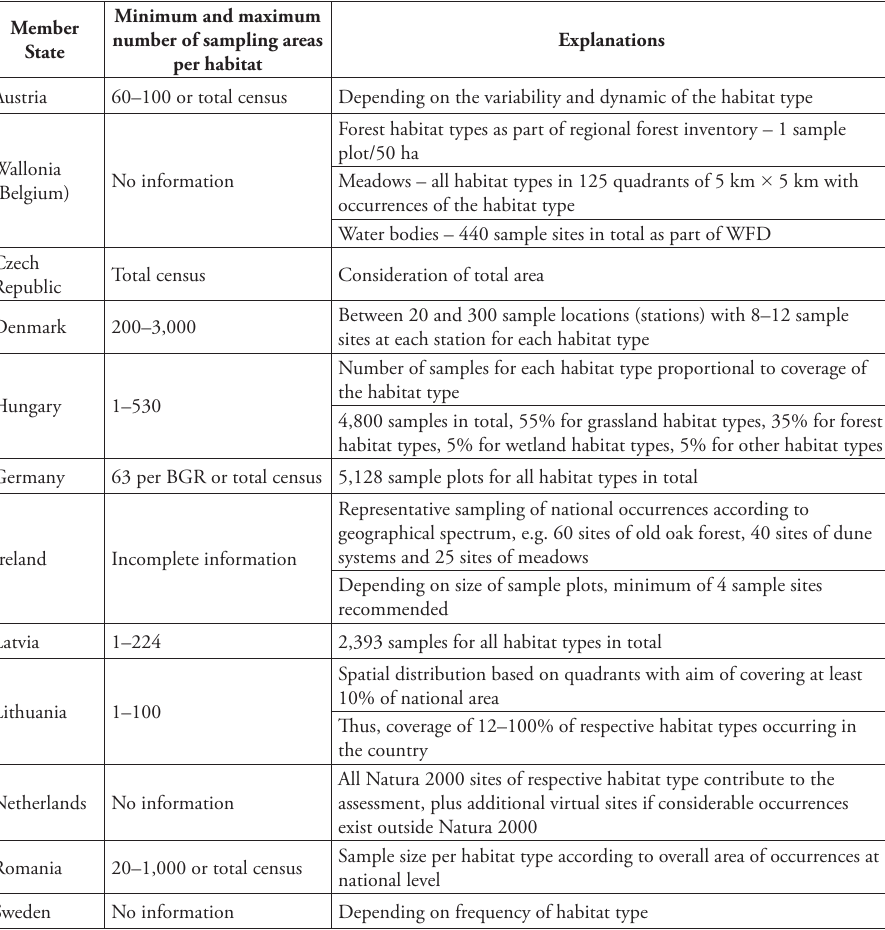
Table 1. Number of sampling areas for habitat types in Member States. BGR: biogeographical region; WFD: Water Framework